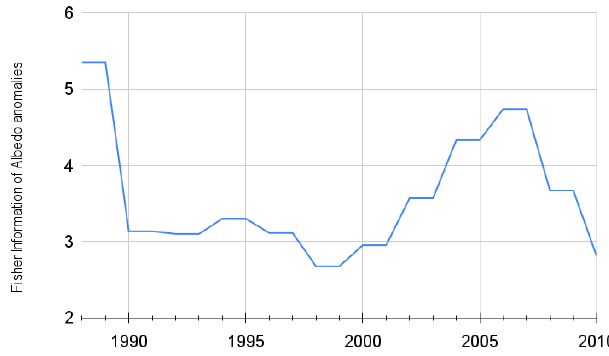
Figure 2. Fisher information for July shortwave terrestrial albedo time series from GLASS data for the Northern